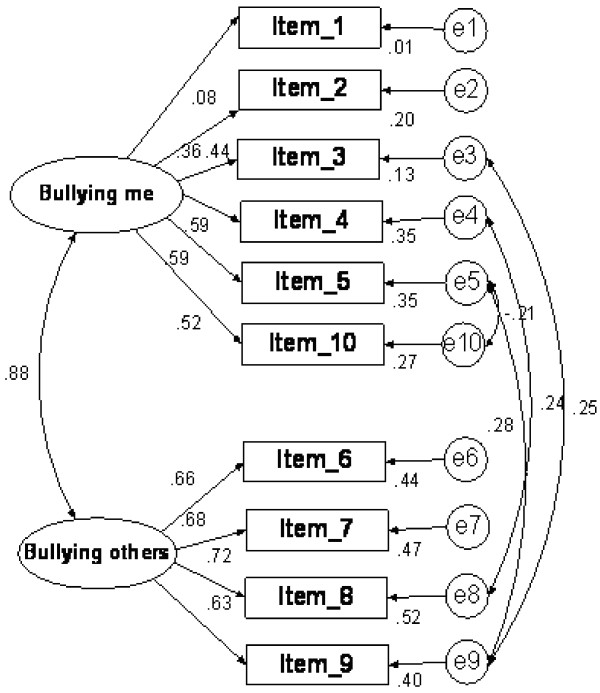
Confirmatory factor analysis (CFA) of Bull-M test: Standardized estimates; Statistics: χ2 = 35.8, df = 30, p = 0.21.